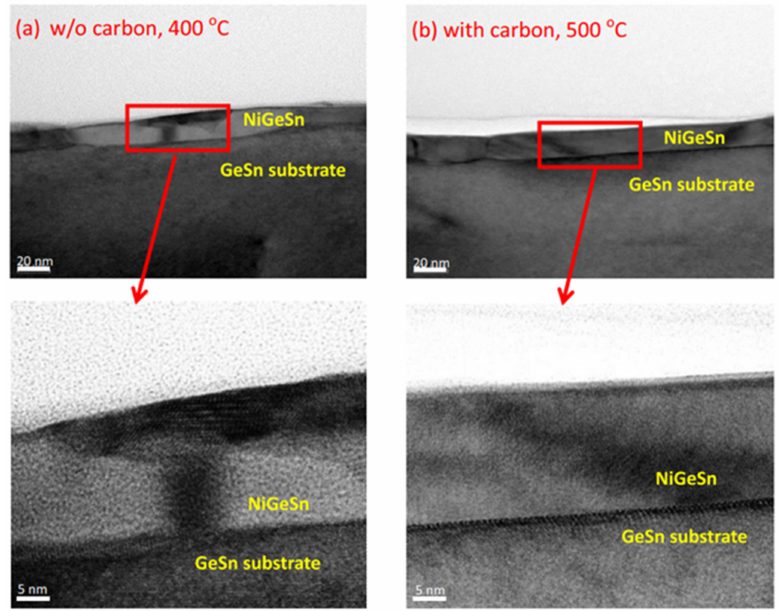
Figure 15. TEM images for Ni–GeSn interface ( a ) annealing at 400 ◦ C without C and ( b ) annealing at 400 ◦ C with C. Reproduced from [187], IOP Publishing, open access, 2015.